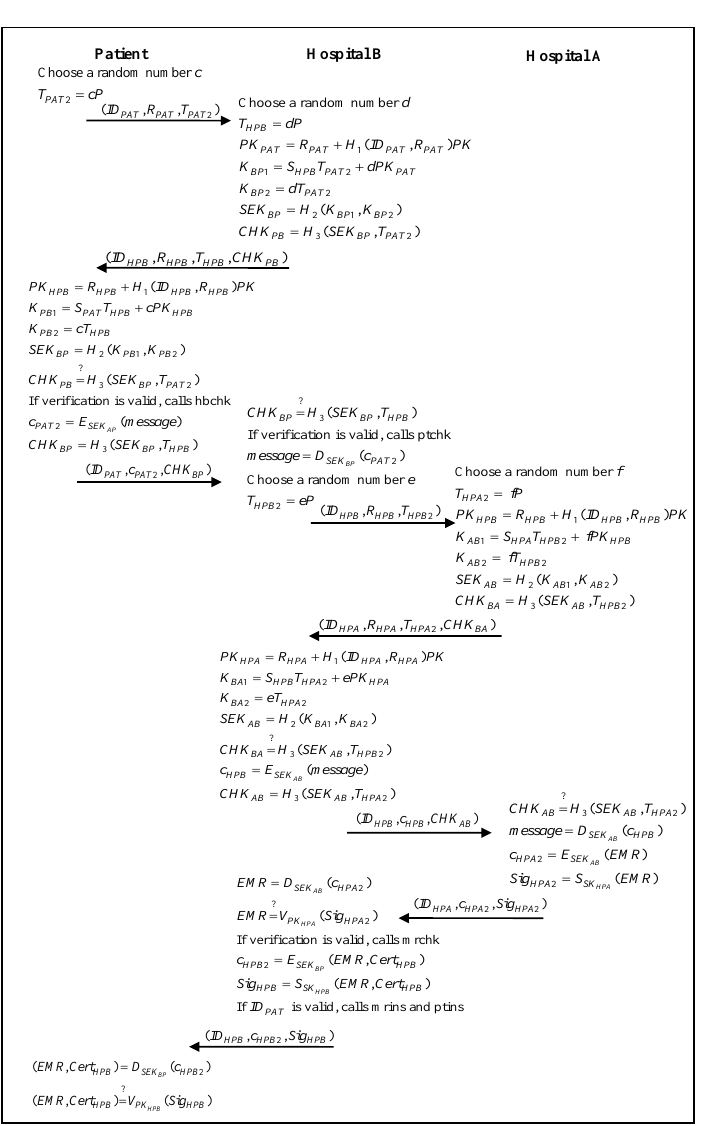
Figure 6. The inter-hospital authentication and communication phase of the proposed scheme.